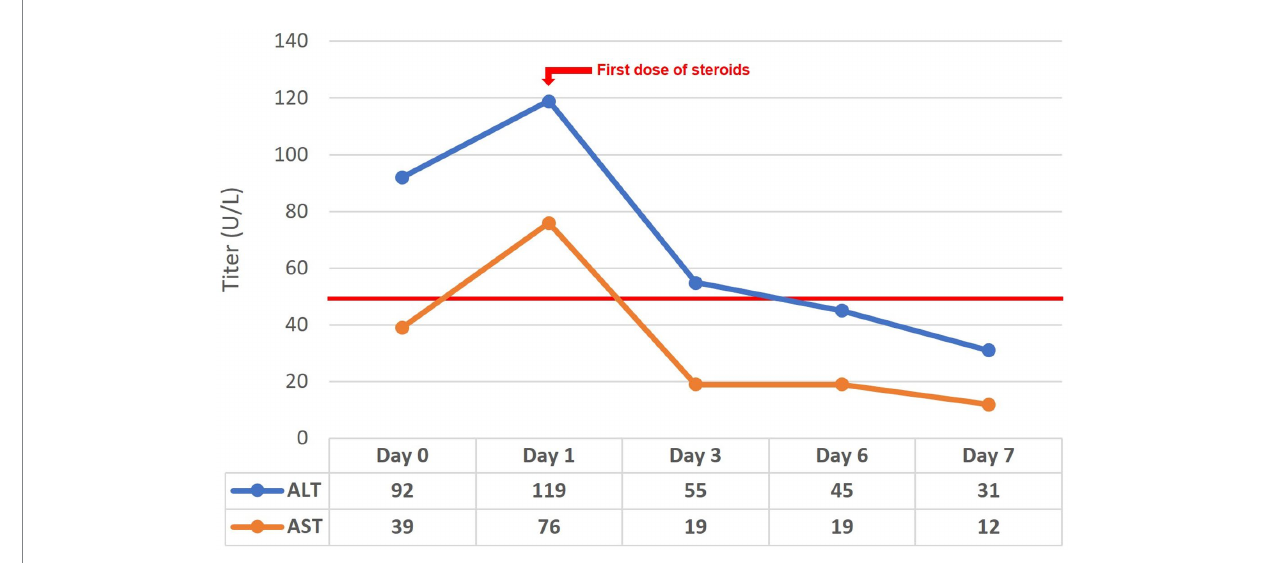
FIGURE 4 Change of liver enzymes over